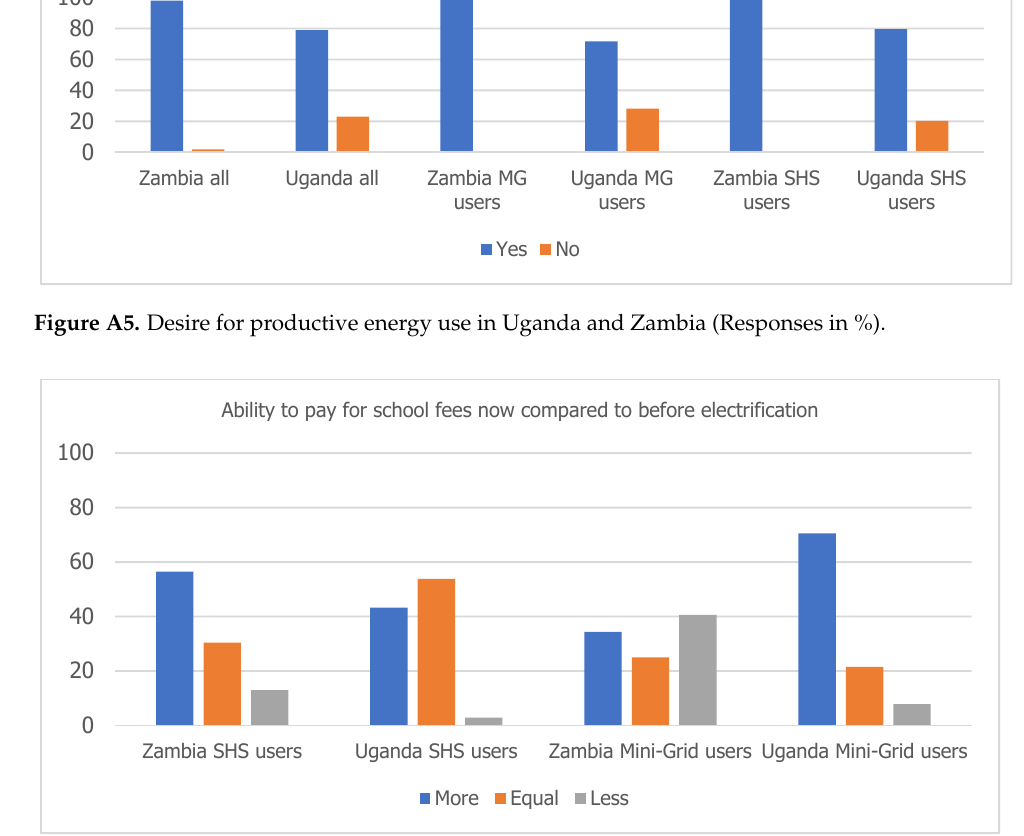
Figure A6. Impact of electrification on ability to pay school fees among various subgroups; Responses in %.